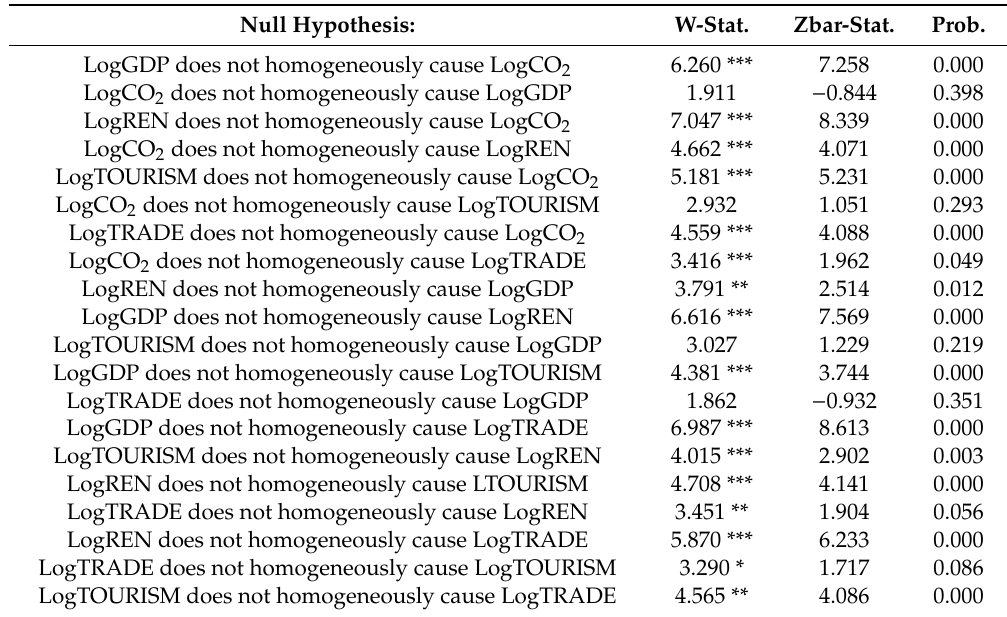
Table 8. Dumitrescu–Hurlin pairwise causality test. Null Hypothesis: